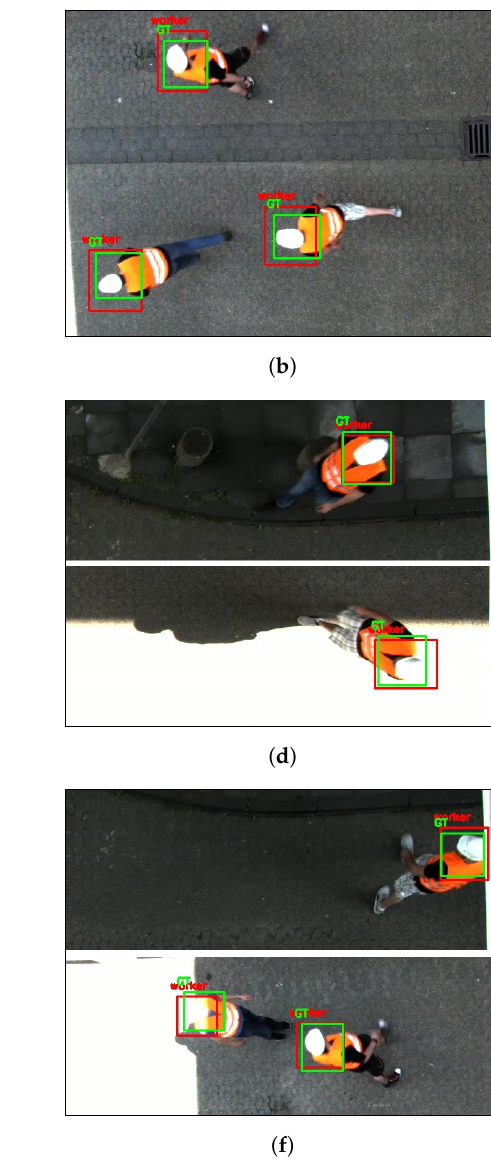
Figure 6. Comparing the detection results of YOLO trained on different datasets. Red rectangles display YOLO’s detections whereas green rectangles indicate manually labeled ground truth. ( a , c , e ) show the results of a detector trained on our real world dataset only. The right column illustrates the detection improvements for the same image sections if particular synthetic data is additionally provided for training. In ( b ), the general accuracy is improved by extending the training dataset by similar data. In ( d ), detections in under- and overexposed areas are improved by adding samples with different lighting conditions. In ( f ), workers can be detected despite slight occlusions and dramatic overexposure after adding a large amount of data